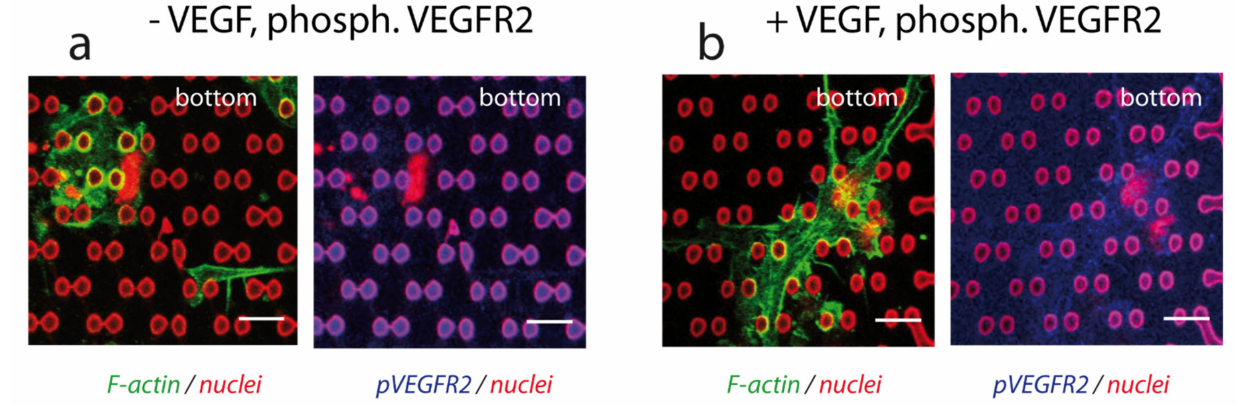
Figure A8. VEGF accessibility. ( a , b ) Phosphorylated VEGFR2 labelling, with or without VEGF stimulation. Cells were incubated 10 min without ( a ) or with ( b ) VEGF 50 ng/mL (see Materials and Methods for details), and were immediately fixed and labelled for phosphorylated VEGFR2. Bottom plane. Left, F-actin (green)/nuclei (red). Right, pVEGFR2 (blue)/nuclei (red). Cells were fixed 2 days after cell seeding. Denoised images, bar 10 µ